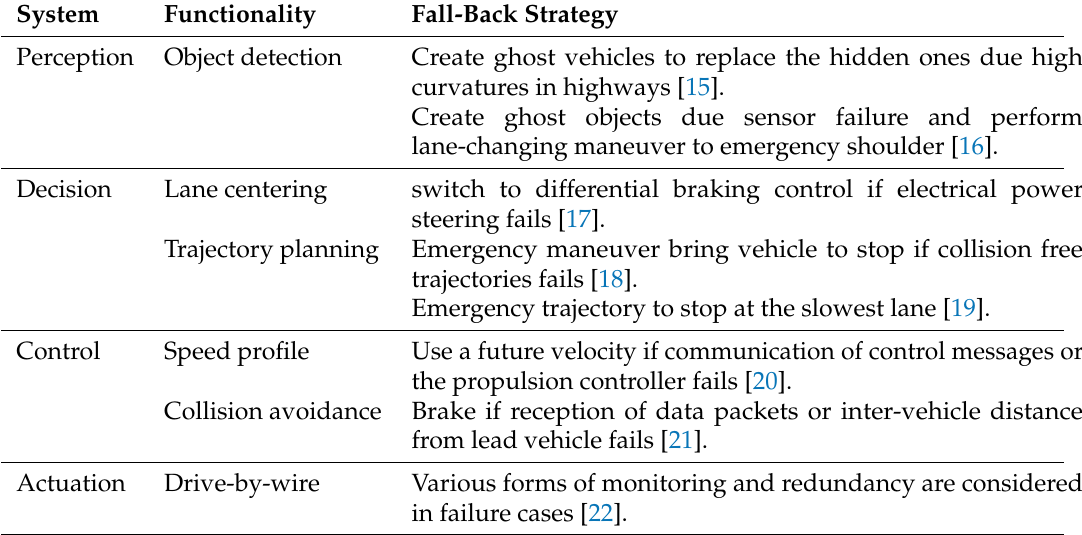
Table 1. DDT fall-back strategies due automated driving system